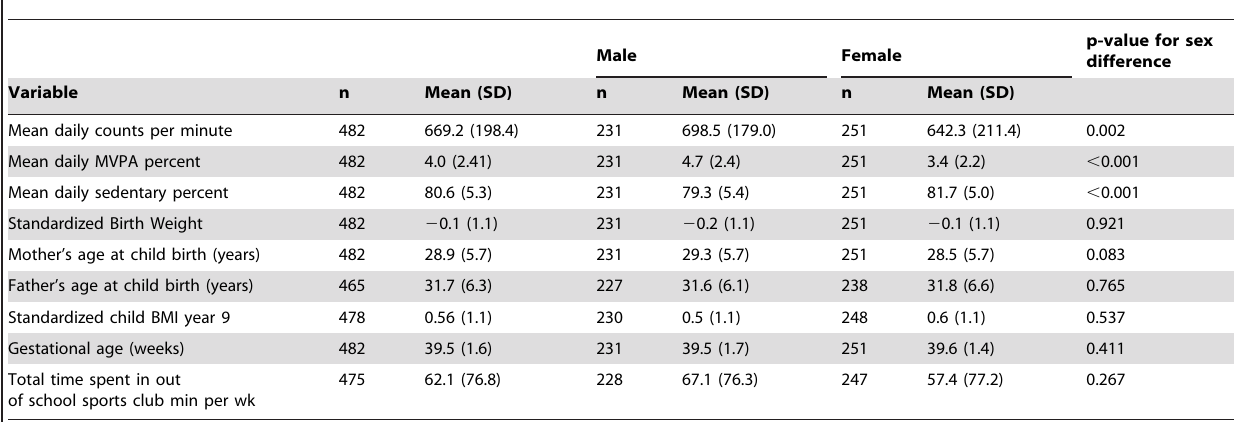
Table 1. Descriptive statistics, by sex, for continuous variables.